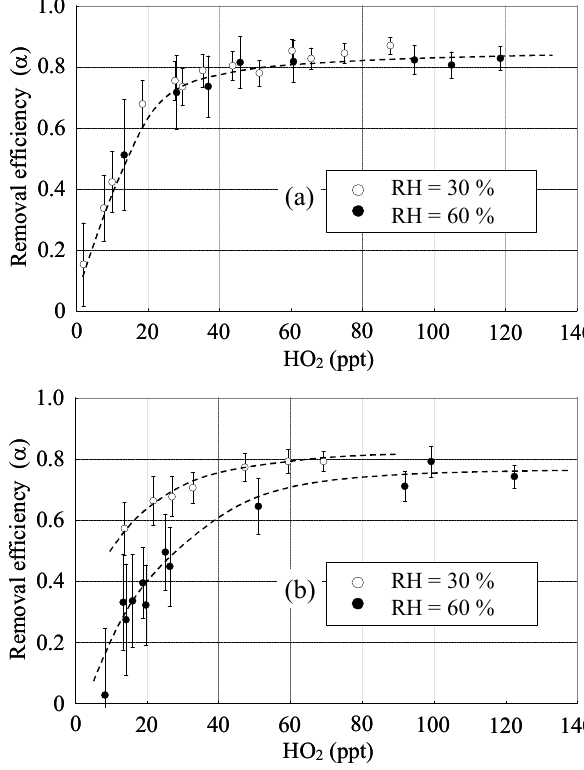
Fig. 4. Removal efficiency α for two different relative humidities as a function of initial HO 2 radical concentration: panel (a) shows the results with glass as filling material, panel (b) is for